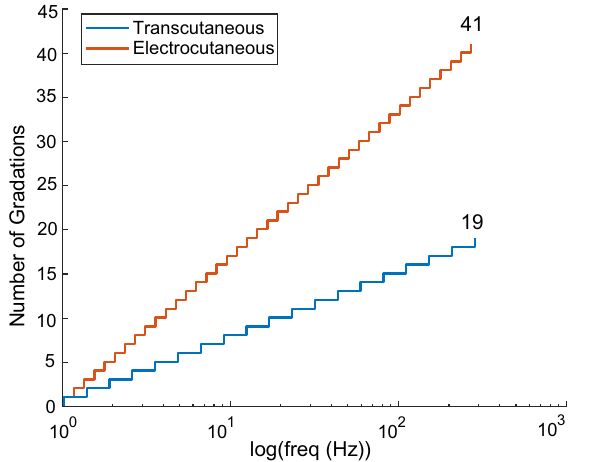
Figure 4. Transcutaneous (blue) has half of the number of sensory gradations than electrocutaneous (red) stimulation does.